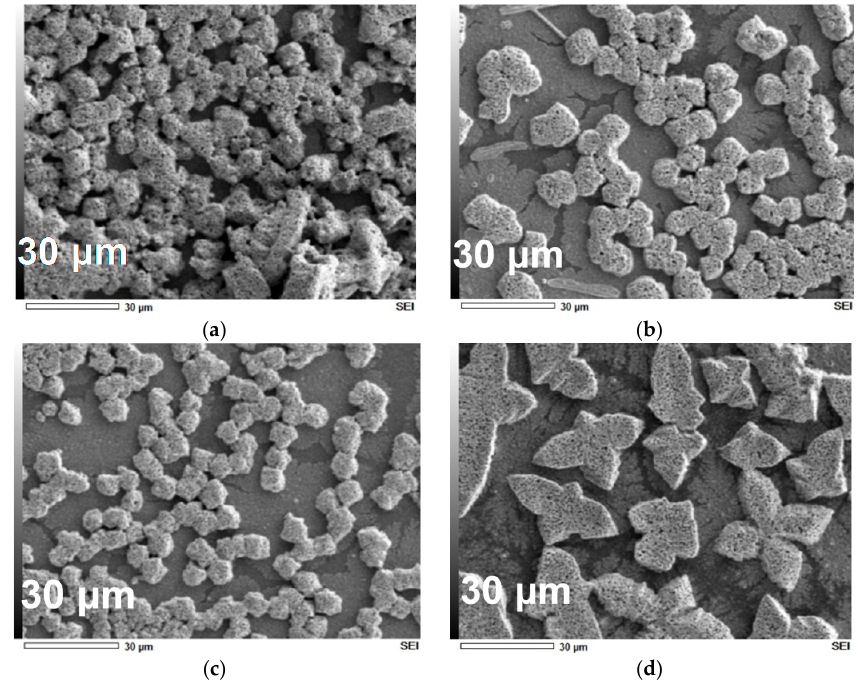
Figure 6. Scanning electron microscopy (SEM) images of FTO/TiO 2 /CH 3 NH 3 PbI 3 − x − y Br x Cl y solar cells doped with: ( a ) I; ( b ) I, Cl; ( c ) I, Br; and ( d ) I, Cl, and Br.